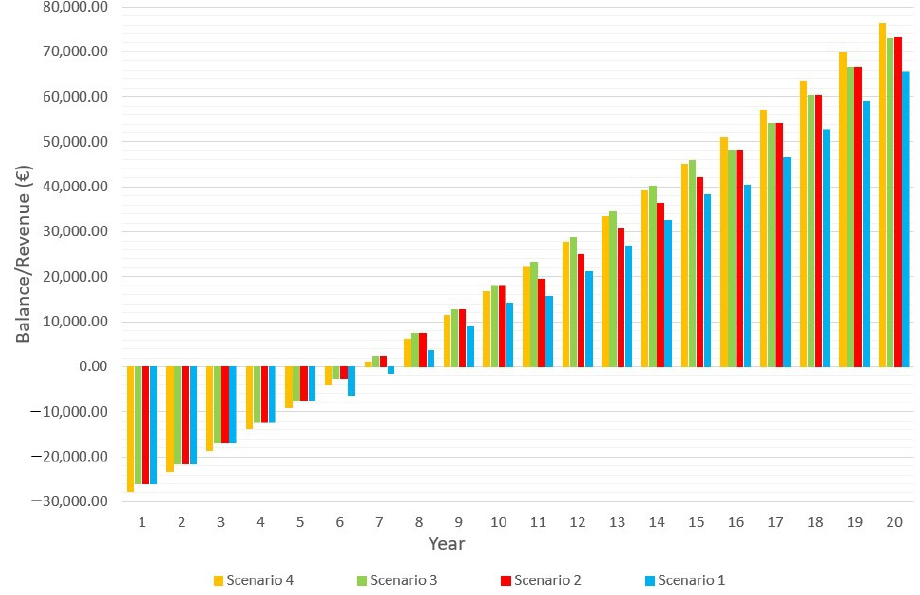
Figure 9. Monetary balance of investment for the different